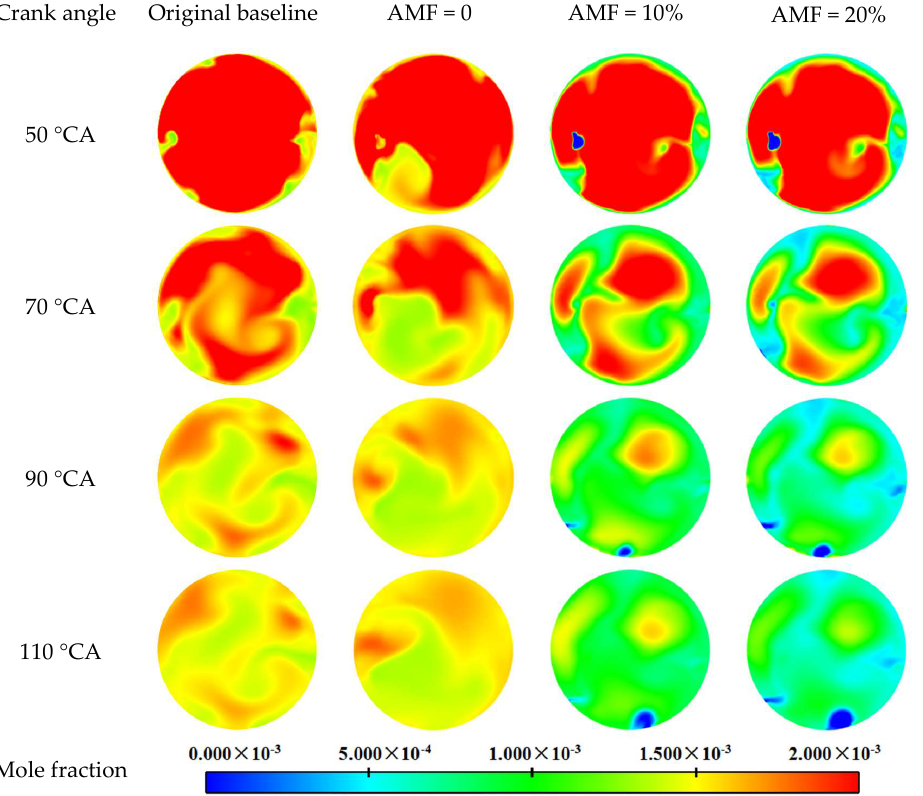
Figure 10. NO evolution with variation of AMF (DI timing = 0 °CA).